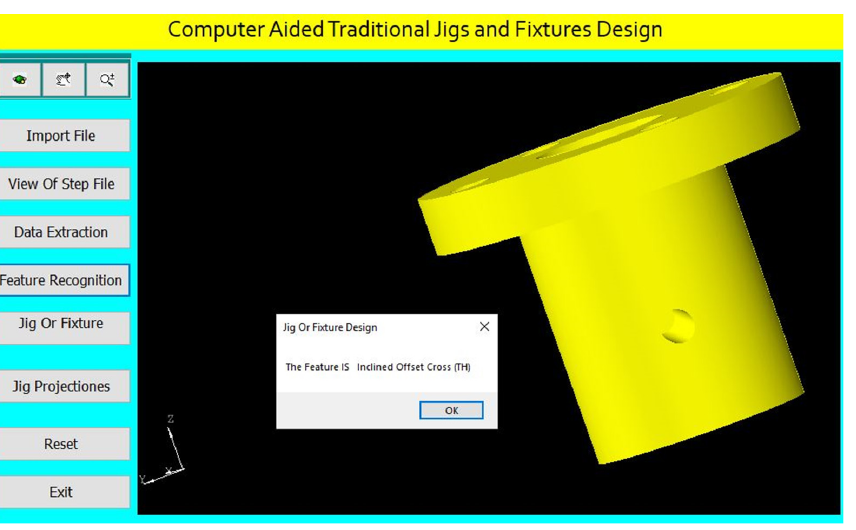
Figure 56. Automatic feature recognition of an inclined offset cross through-hole. The program checks the inclined offset cross through-hole of (4 mm) diameter for identifying the suitable guide bush.